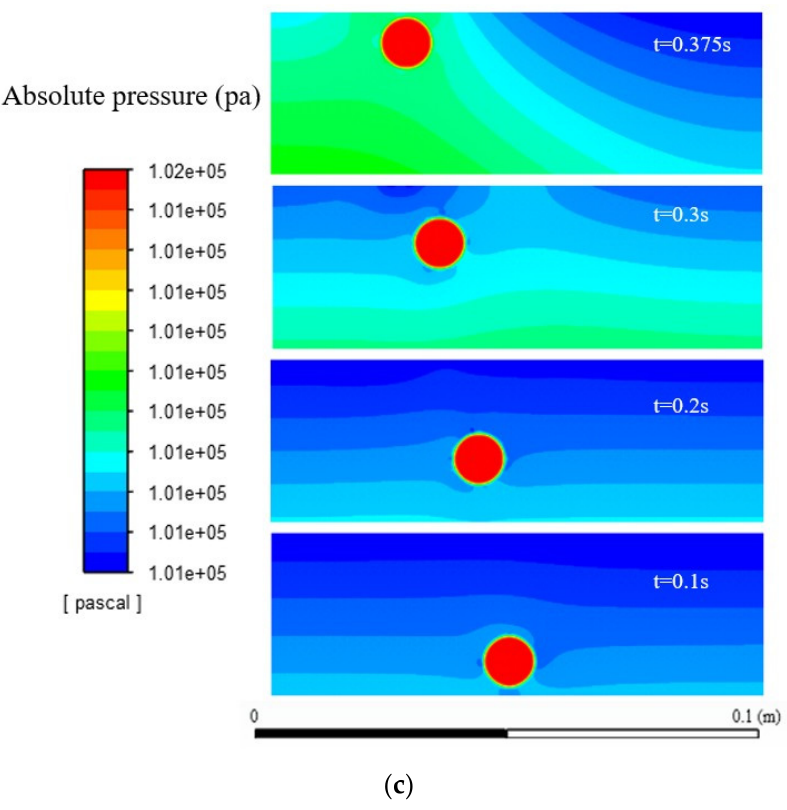
Figure 9. The transient state of the bubble with radius R = 0.006 m and ∆𝑇 = 40 K ( a ) Velocity field ( b ) Temperature field, and ( c ) pressure field.